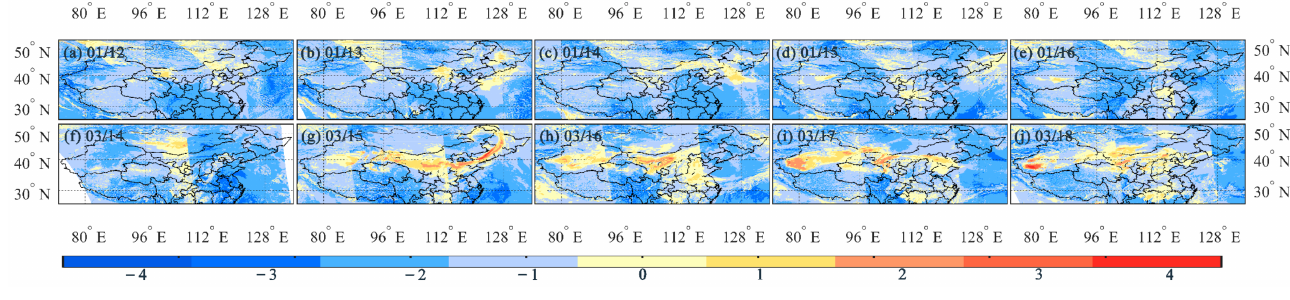
Figure 2. Horizontal distribution of dust in the 1.12 and 3.15 events, indicated by TROPOMI